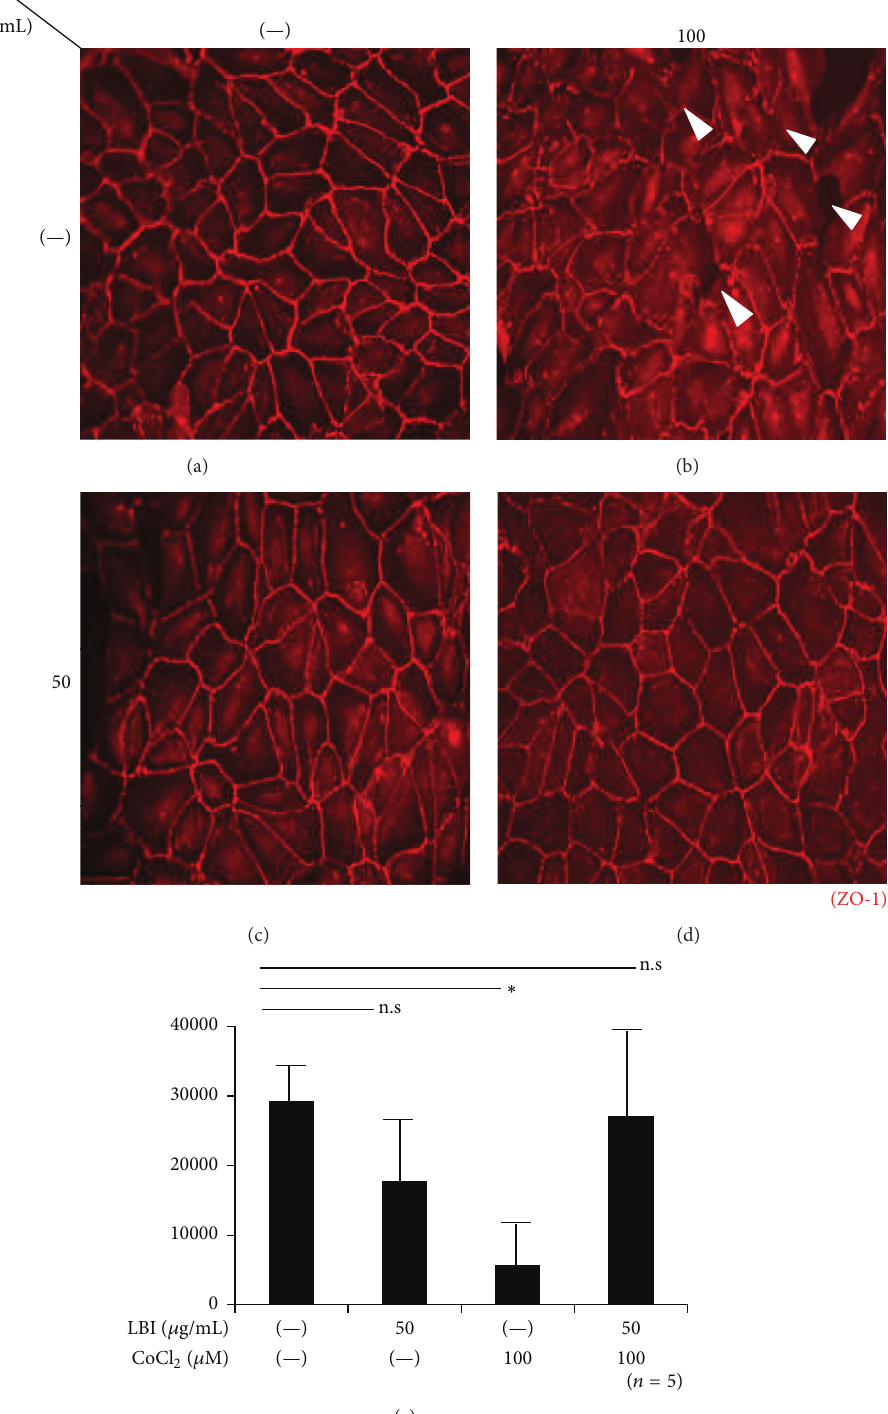
Figure 1: Photomicrographs of ARPE-19 cells in culture immunostained for ZO-1, a TJ protein. The findings demonstrate that LBI protects TJs from disruption by hypoxia-induced stress. Immunofluorescence microscopic images showing the presence of ZO-1 (red) surrounding the ARPE-19 cells in culture. Exposure of the cells to CoCl 2 causes a disruption of the TJs ((a), (b) arrow head). When the CoCl 2 -exposed ARPE-19 cells were pretreated with LBI, there were no significant differences in the ZO-1 pattern from that of the control ((c), (d)). The integrity of the TJs was also estimated using signal intensity measurements ( 𝑛 = 5 ) (e). Although there was a significant decrease in the signal intensity after the addition of CoCl 2 compared to that of the controls, the difference was not significant when the cells were pretreated with LBI prior to the addition of CoCl 2 . ∗ 𝑃 < 0.05 , nonrepeated ANOVA. LBI, lecithin-bound iodine; n.s, not significant; TJs, tight junctions; ZO-1, zonular